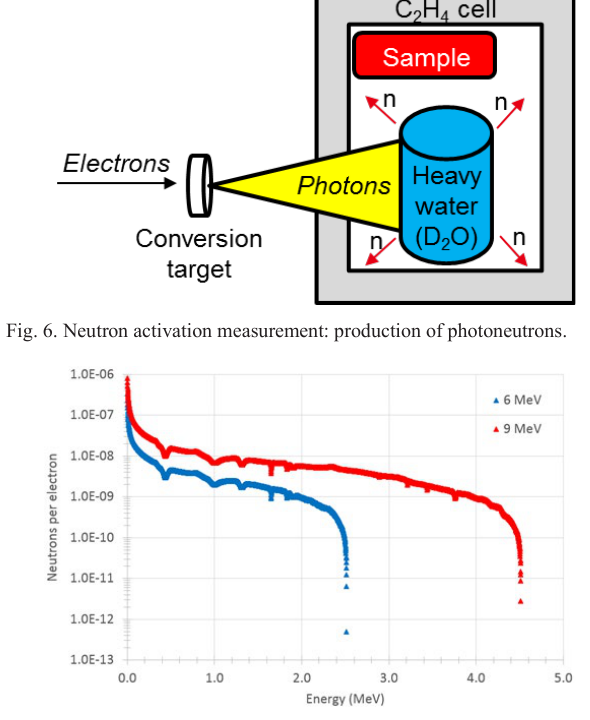
Fig. 3. Photon activation measurement: delayed gamma-ray detection step.